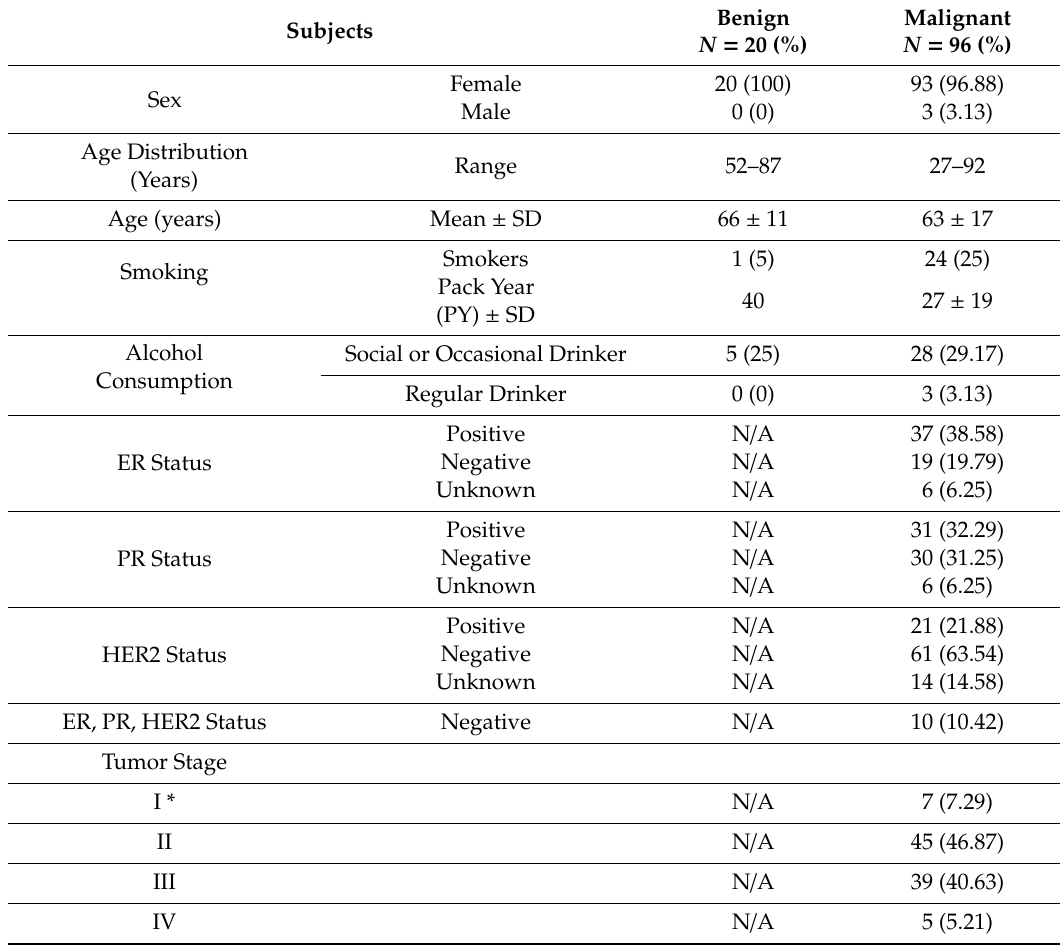
Table 1. Demography of human benign and malignant tissue samples from Ontario Tumor Bank: this table illustrates tobacco exposures, alcohol consumption, hormone receptor status (ER, PR, HER2), and tumor stage status of the benign and malignant human tissue samples used in this study. Samples were age-matched; the majority of samples are from female patients, only three samples are male. Hormone receptor status of weak and intermediate was considered neither negative nor positive. Age and pack year were presented as mean ±